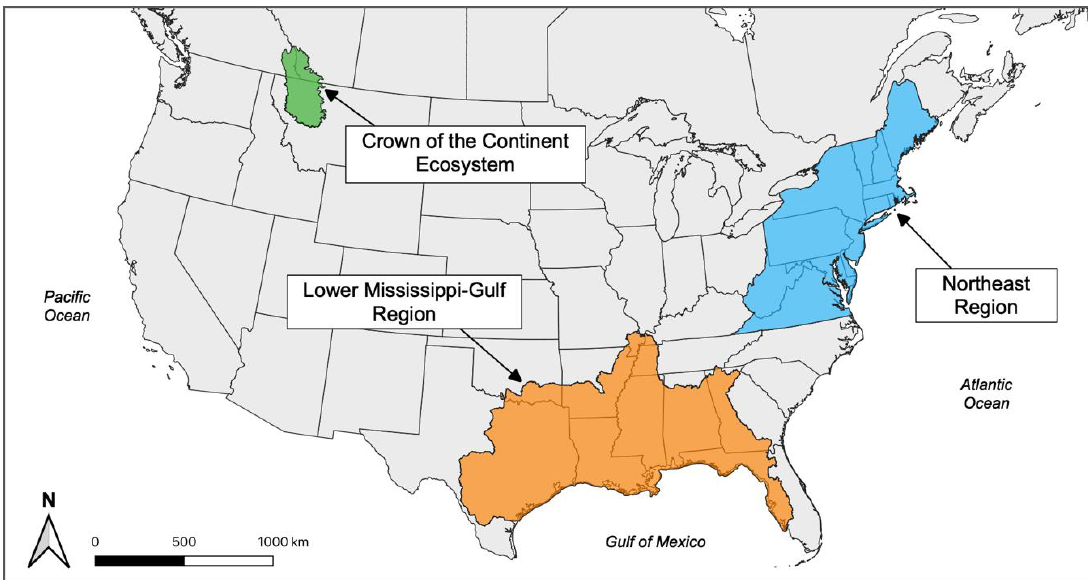
Figure 1. Map of the U.S. and Canada showing the region associated with each of the three research projects. The basemap was created using the North American political boundaries [36] with the Albers equal area conic projection for the contiguous United States.